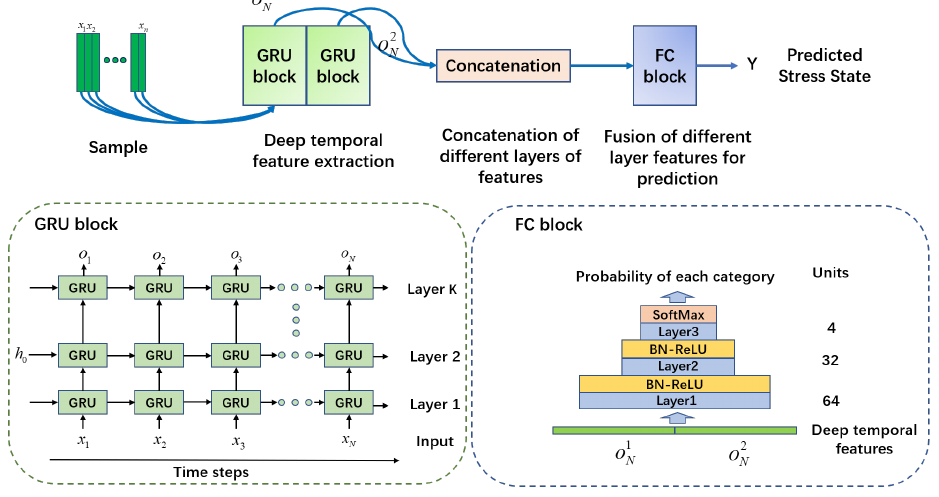
Figure 8. Psychological stress classification